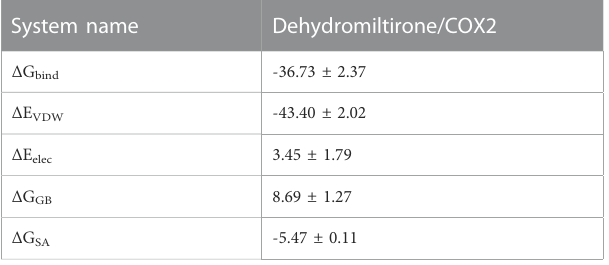
TABLE 1 Energy components and combined free energy are calculated using the MM/GBSA